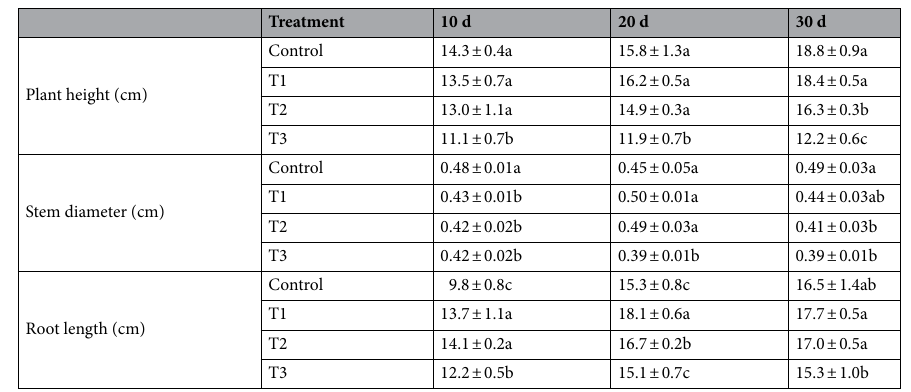
Table 3. Effects of drought stress on the plant height, root length and stem diameter of Phedimus aizoon L. The data are the means ± SDs of three replications. Use different letters to indicate significant differences in average values between the treatments within each individual time ( P ≤ 0.05) based on Duncan’s multiple range test. Control, 75–80% of the MWHC; T1, 55–60% of the MWHC; T2, 40–45% of the MWHC; T3, 20–25% of the MWHC.